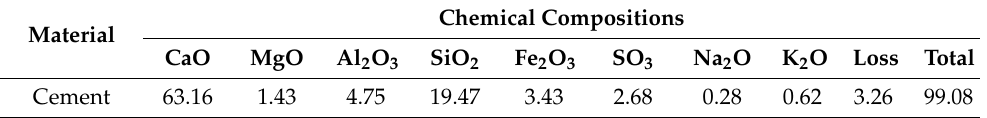
Table 3. Chemical compositions of cement